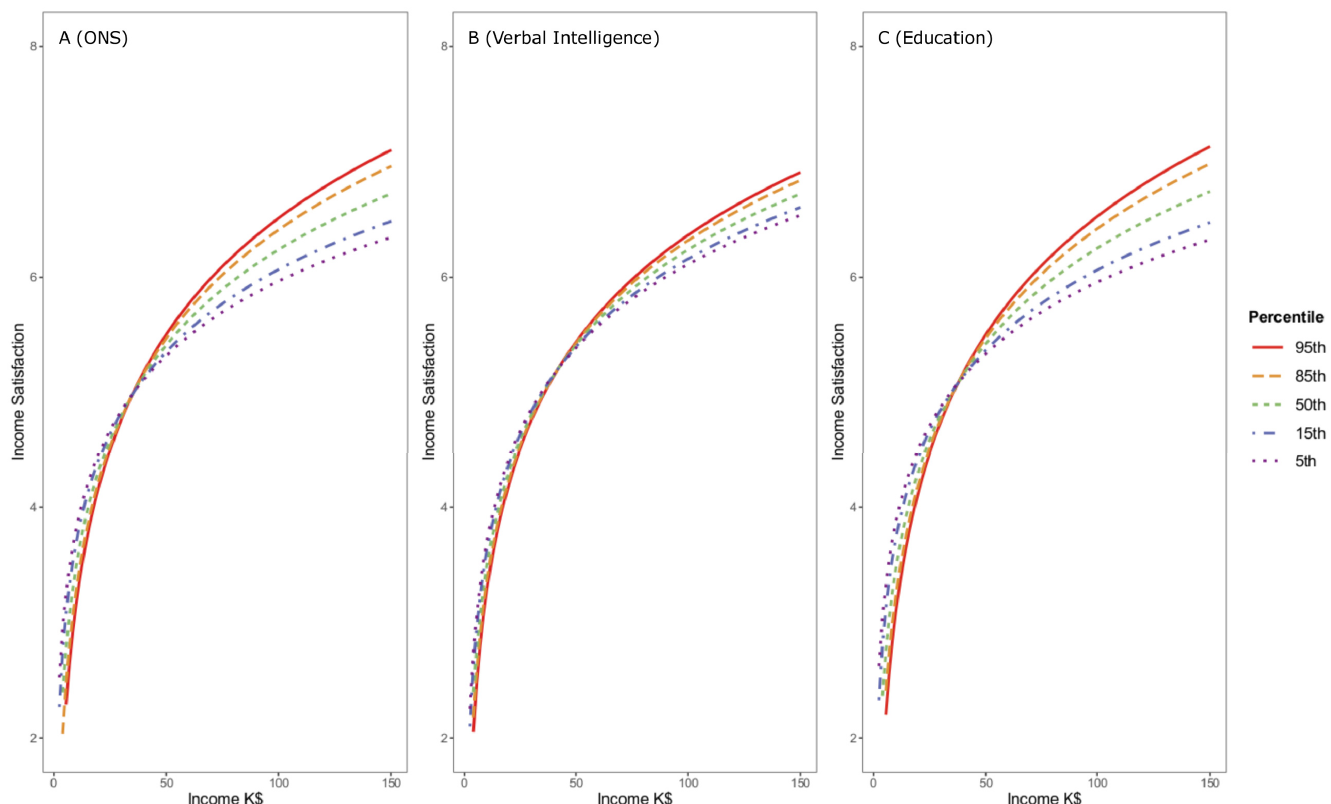
Fig 4. Estimated means of income satisfaction plotted as a function of income (thousands of $) and objective numeracy (panel A), Verbal Intelligence (panel B), and Education (panel C). Each moderator added significant predictive power to the model, meaning that each one altered the predictive power of income on income satisfaction, independent of the